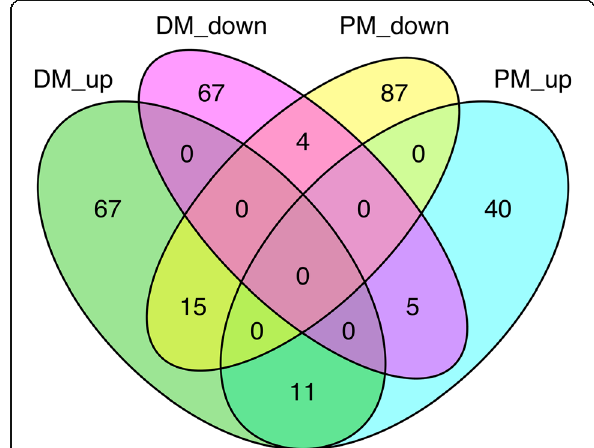
Fig. 2 Numbers of upregulated and downregulated miRNAs in PM/ DM after treatment. miRNA expression levels before and after treatment in DM and PM patients were averaged, and miRNAs were selected using the twofold filtering criterion. The Venn diagram shows the numbers of upregulated and downregulated miRNAs in PM and DM